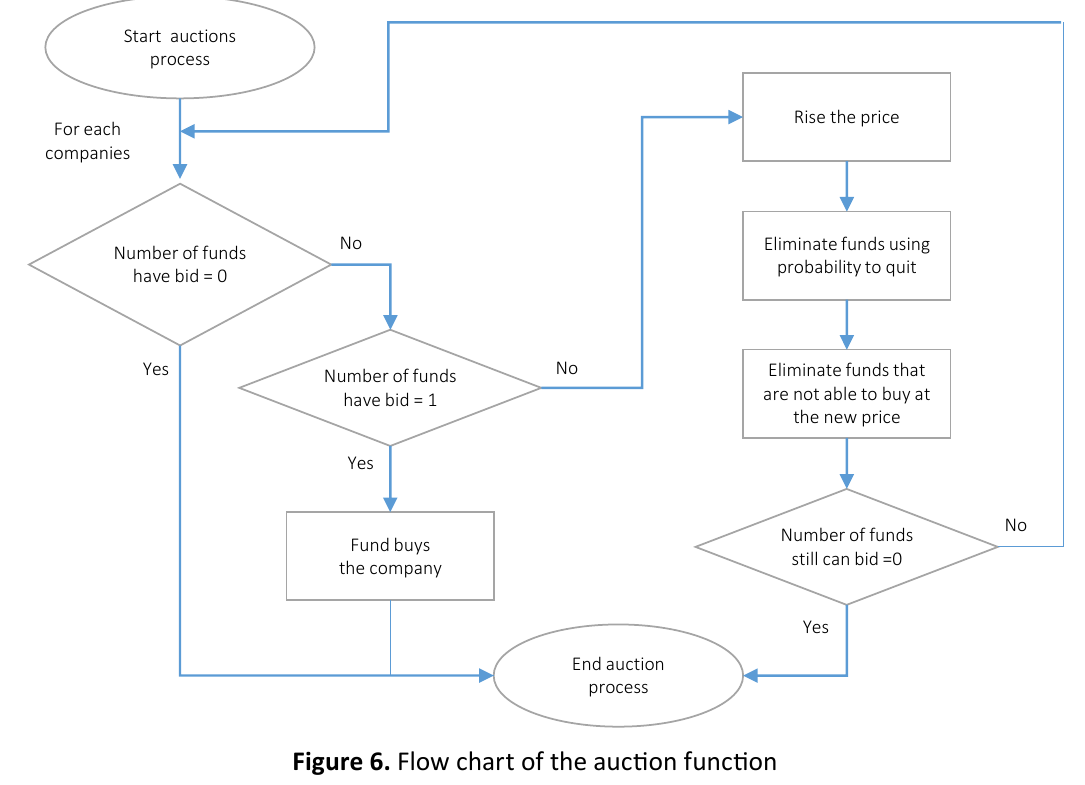
Figure 6. Flow chart of the auction function